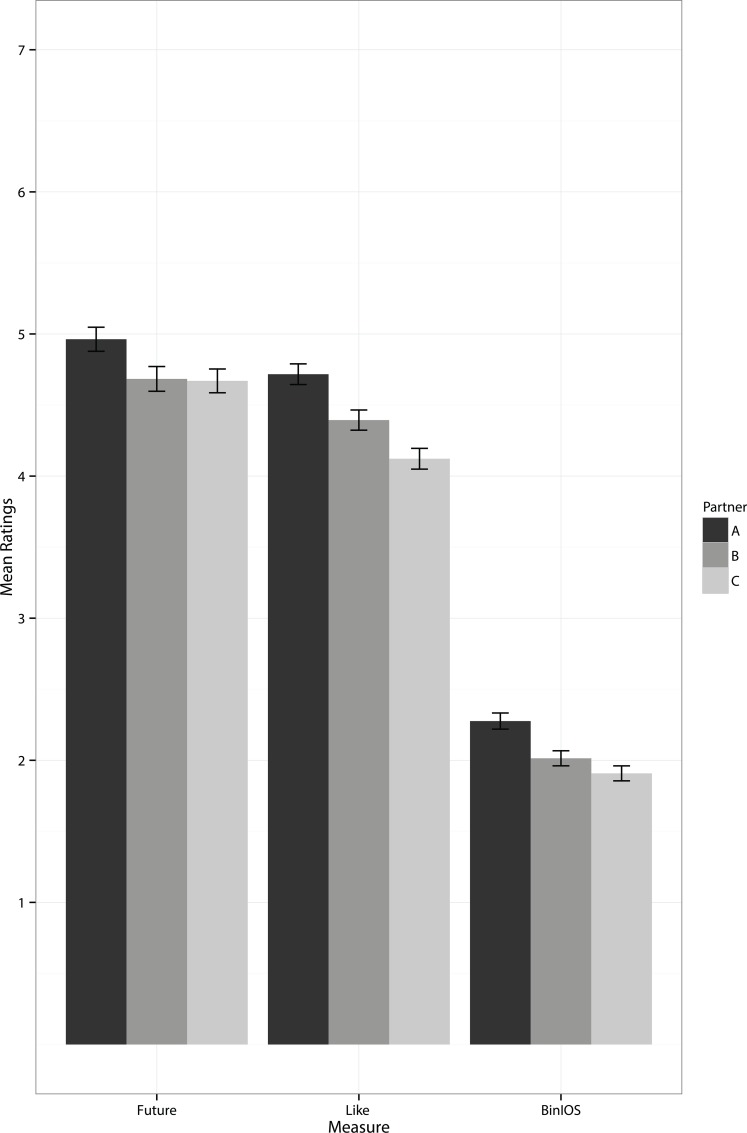
Mean ratings for Partner A (sharing nine of fourteen traits), Partner B (sharing five of fourteen traits) and Partner C (sharing no traits) on desire for future interaction, likeability and binned IOS scale.Error bars show standard error.